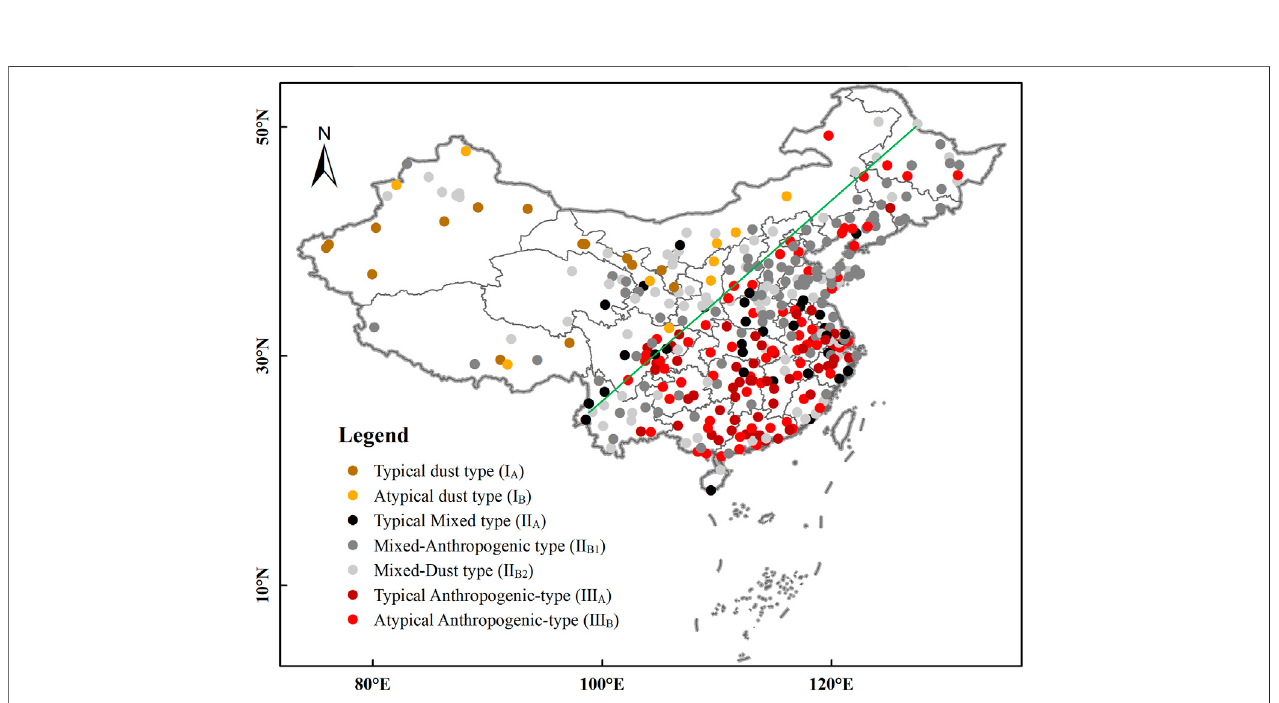
FIGURE 9 | The spatial distribution of urban pollution classi fi cation results based on the PM 2.5 /PM 10 rations using our proposed method. The colors represent the seven different classi fi cation methods and the green line indicates the Hu-line.